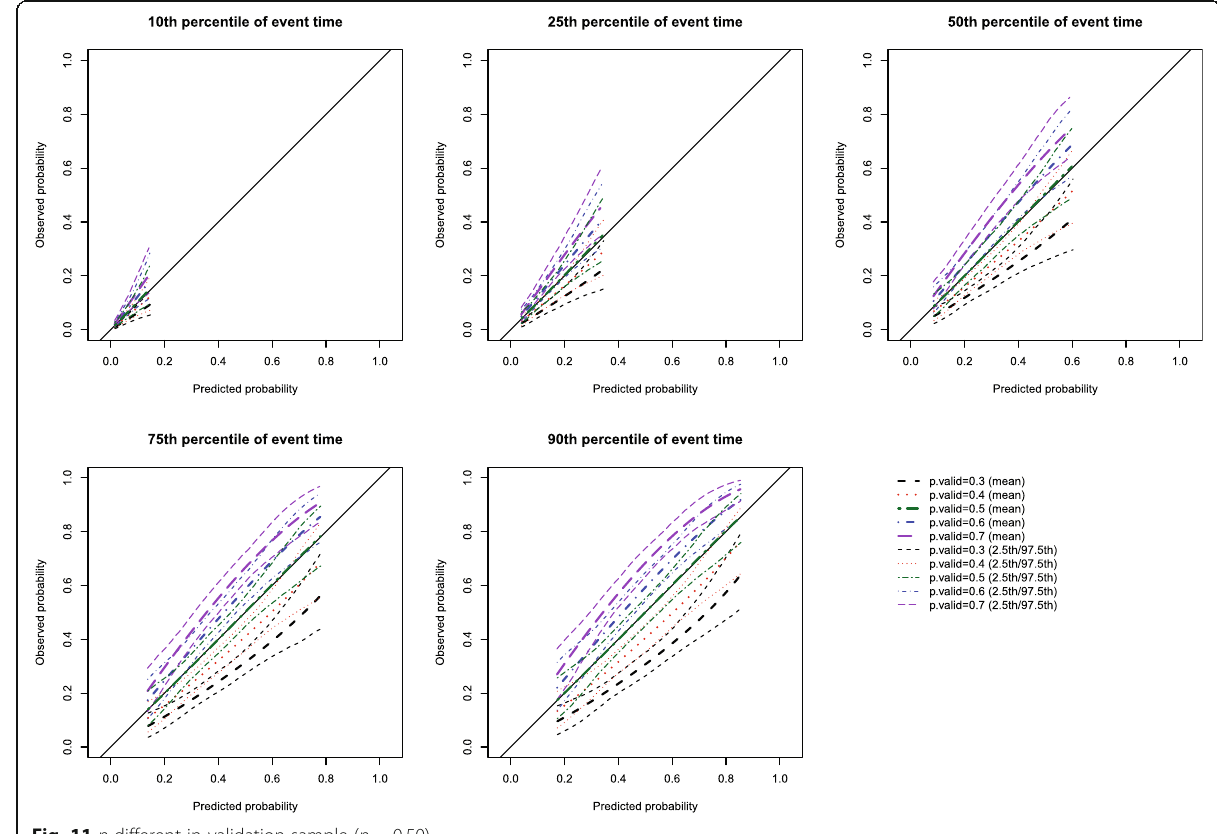
Fig. 11 p different in validation sample ( p =